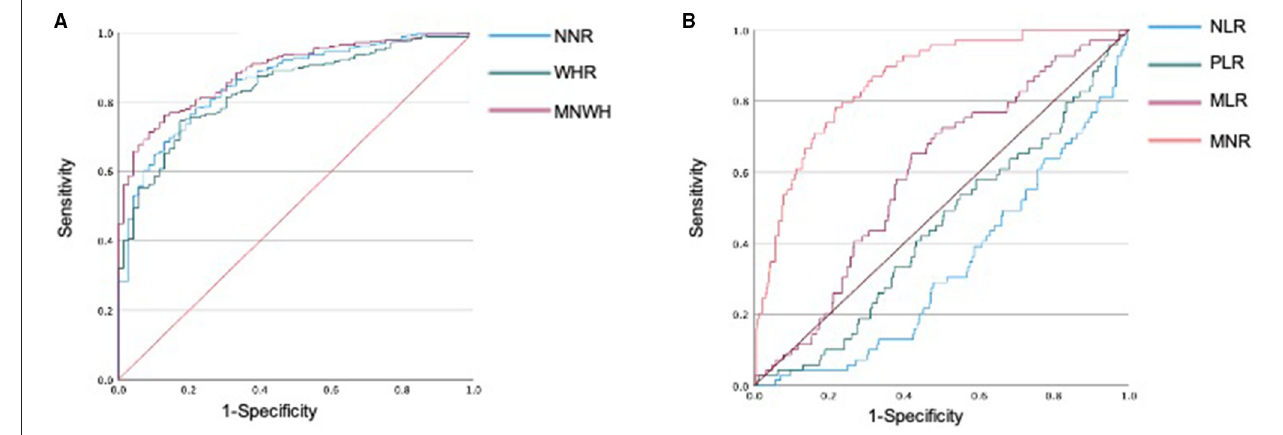
FIGURE 2 | Receiver operating characteristic (ROC) analysis to evaluate the diagnostic value of hematologic markers for COVID-19. (A) Diagnostic values of neutrophils and lymphocytes in differentiating SARS-CoV-2 positive patients from negative patients. (B) Diagnostic values of NLR, MLR, and PLR in differentiating